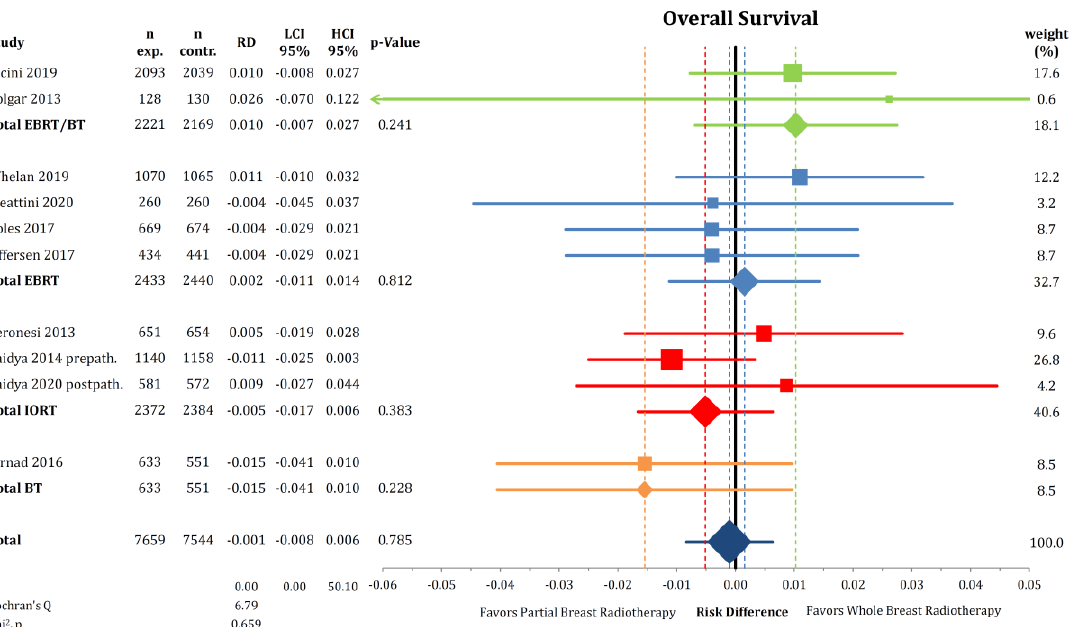
Figure 3. Comparison of overall survival by risk difference between partial- and whole breast radiation using a forest plot and the inverse variance heterogeneity model. Trials are grouped by radiation technique. Quadrats and diamonds represent individual trials and pooled effect sizes with corresponding 95% confidence intervals.